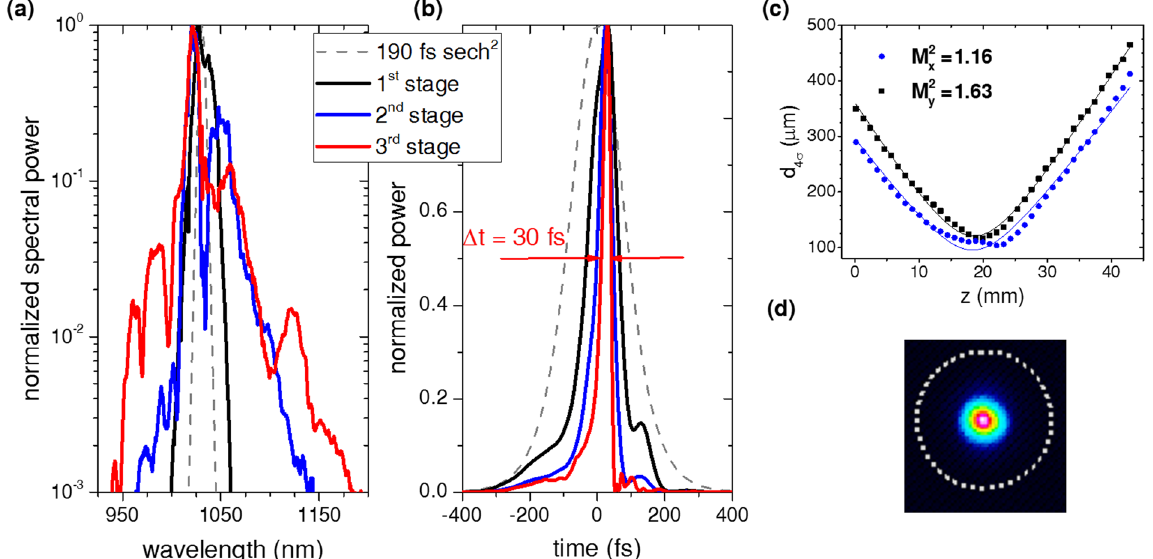
Figure 2. ( a ) Broadened spectra measured with an OSA. ( b ) Retrieved FROG traces with 97 fs (black line), 50 fs (blue line), 30 fs (red line) full widths at half maximum. The legend applies to ( a , b ). As a reference a sech 2 -shape spectrum and pulse corresponding to the oscillator input is shown. ( c ) M 2 measurement of the beam behind the third broadening stage. ( d ) Focused beam profile extracted from the M 2 measurement shown in (c).